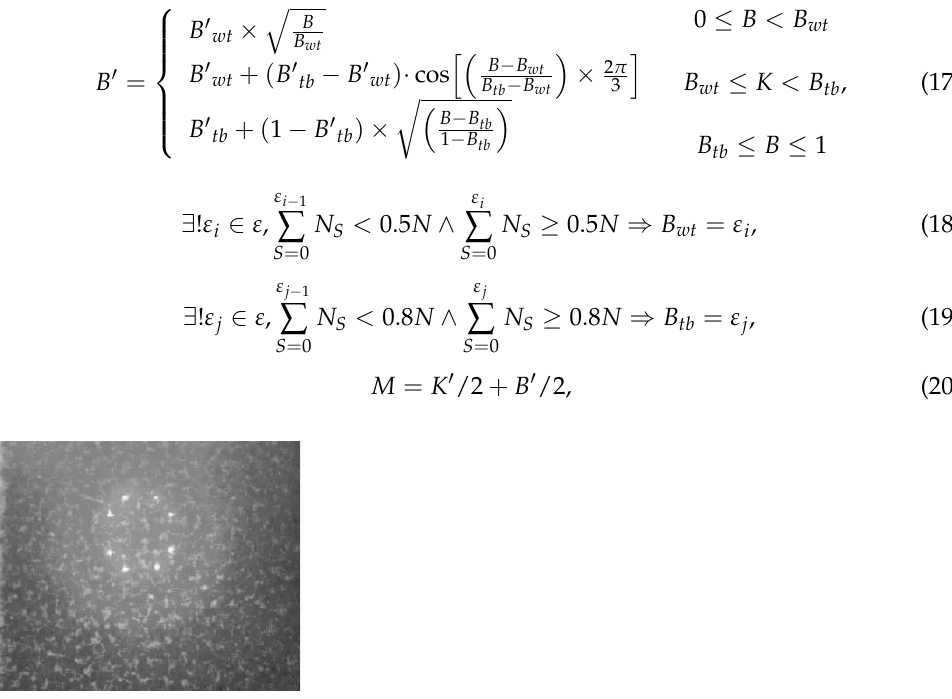
Figure 12. The final enhancement image M .